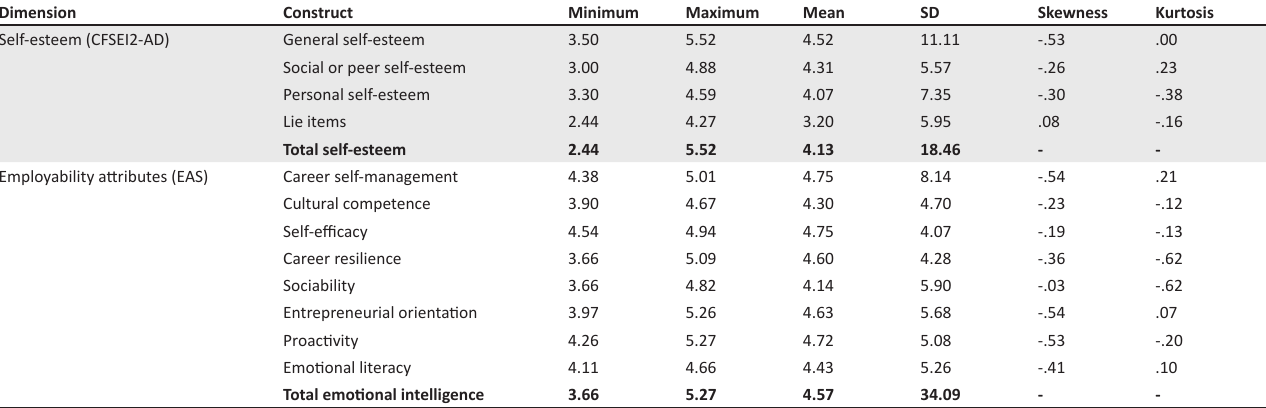
TABLE 2: Descriptive statistics – Culture Free Self-Esteem Inventory and Employability Attributes Scale. Dimension